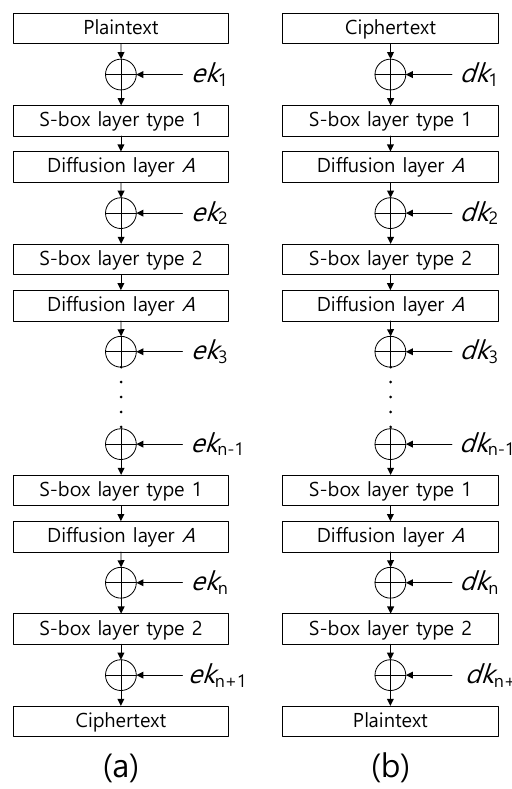
Figure 1. Overview of ARIA ( a ) encryption and ( b ) decryption processes, where ek and dk represent encryption key and decryption key, respectively. Table 1. Instruction set summary for efficient ARIA implementations on 8-bit AVR